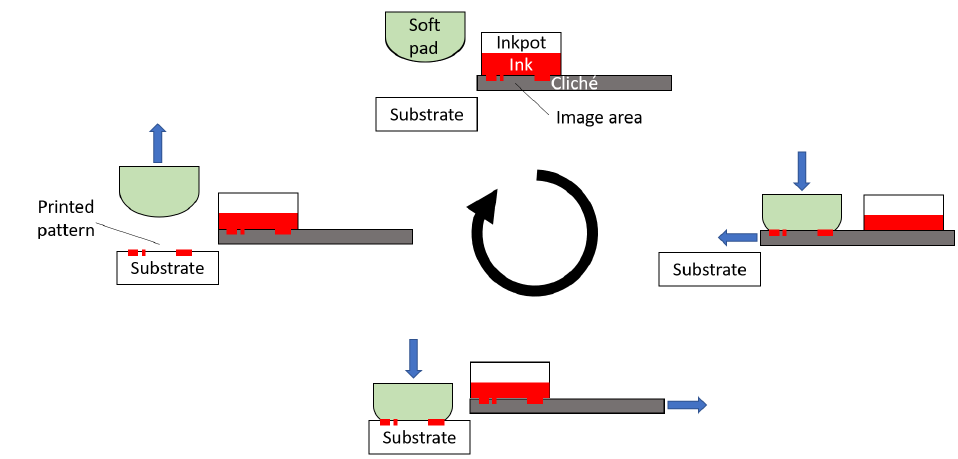
Figure 16. Schematics of pad